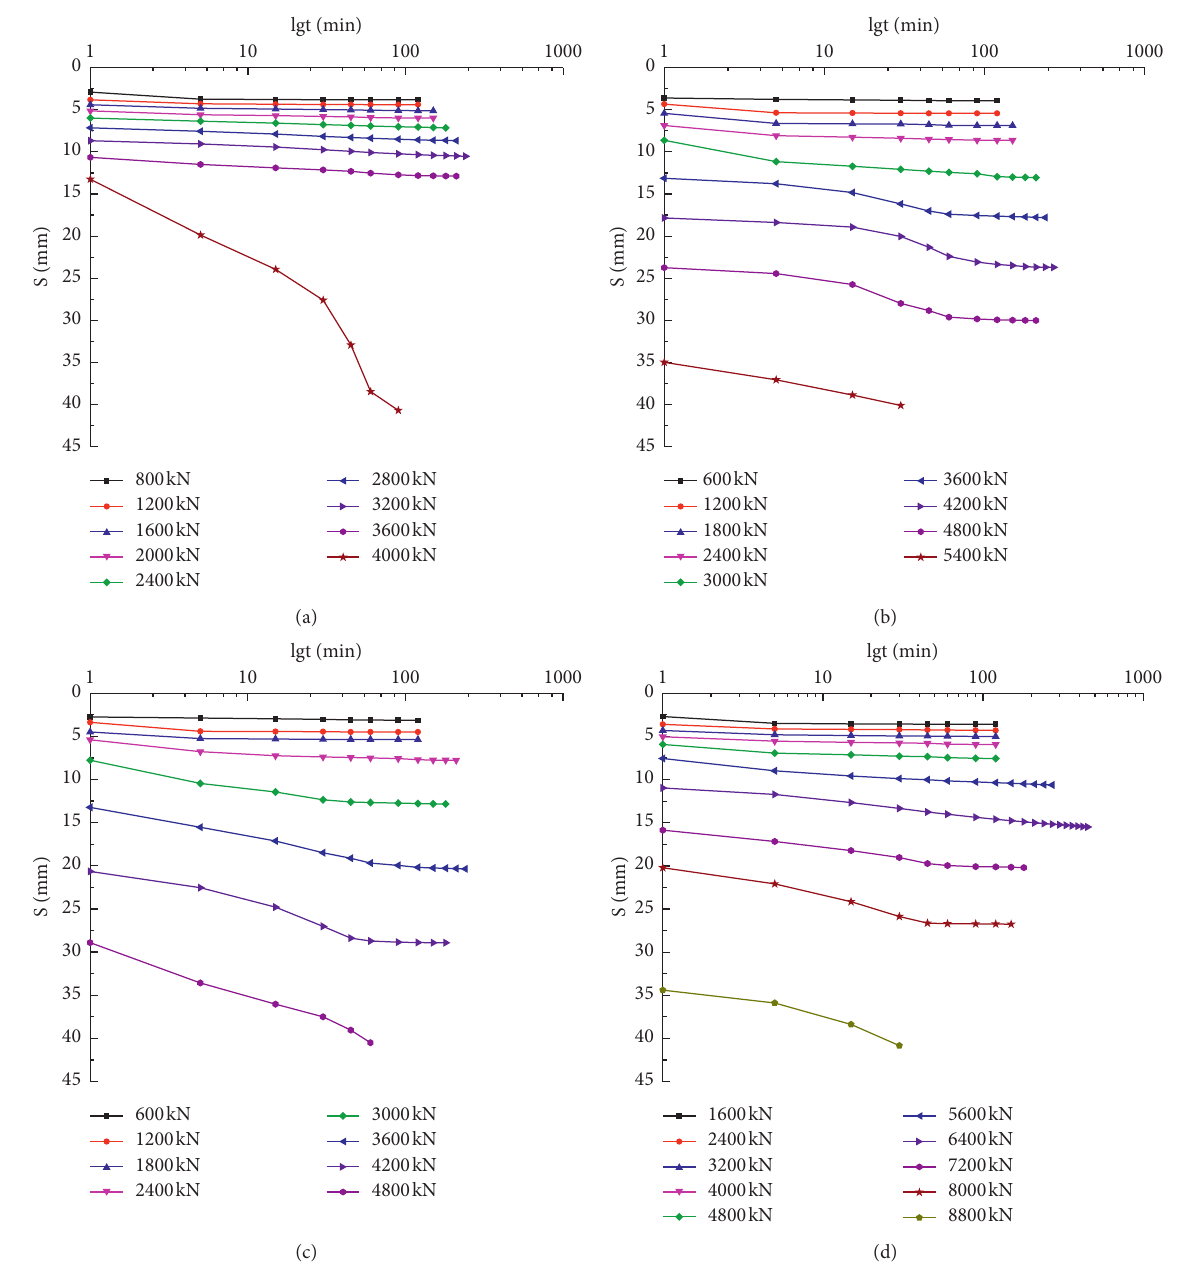
Figure 9: S-lgt curve of each pile. (a) No. 1 pile. (b) No. 2 pile. (c) No. 3 pile. (d) No. 4